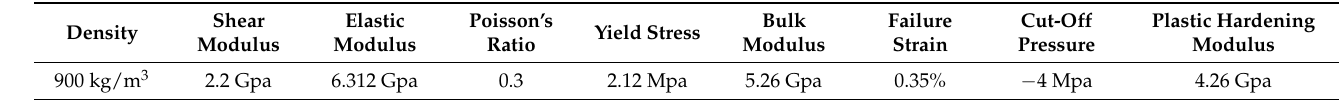
Table 6. Material model of ice.